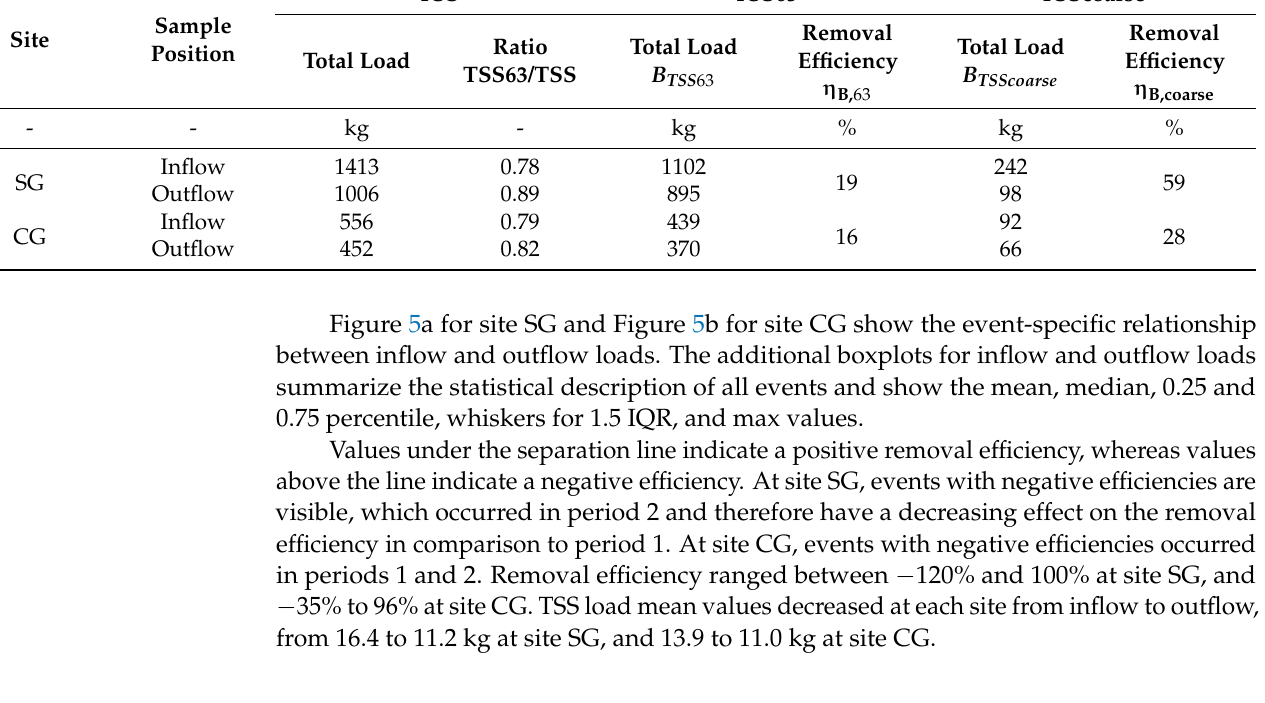
Table 5. Estimated long-term load and removal efficiencies for TSS fractions TSScoarse and TSS63 at sites SG and CG.